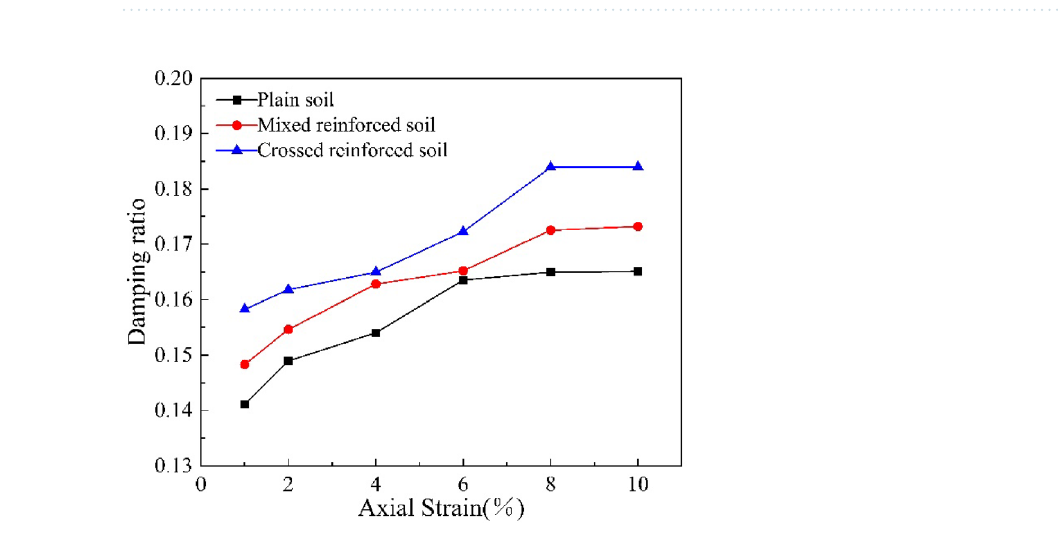
Figure 7. Curves of damping ratio veruss axial